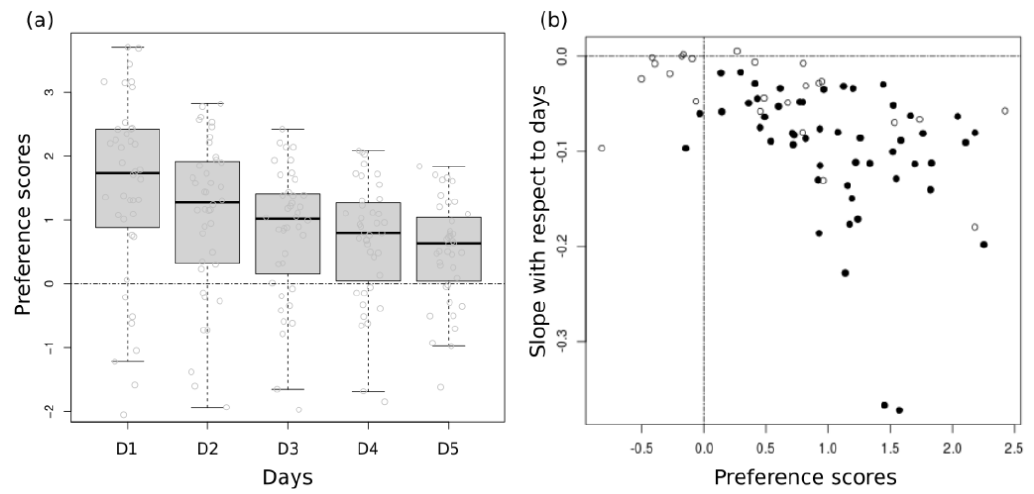
Figure 3. Temporal dynamics of oviposition preference. (a) Distribution of x values (one dot per tube; 40 tubes) a s a function of Day, in the example of population acjy144, “P” treatment. (b) Correlation, over all populations and treatments (75 points), between the preference score (x axis) and its change over days (y-axis). Black dots indicate population/treatment combinations for which the slope was significantly different from zero, after correcting for multiple tests.